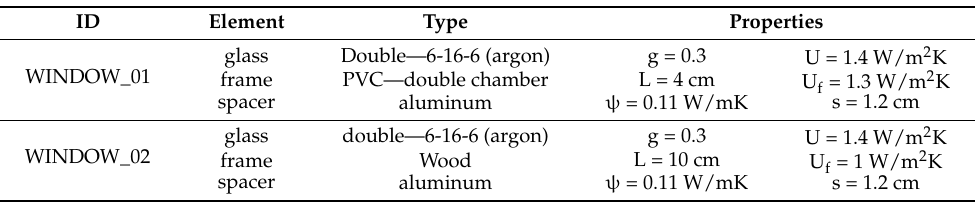
Table 4. Windows typologies adopted as